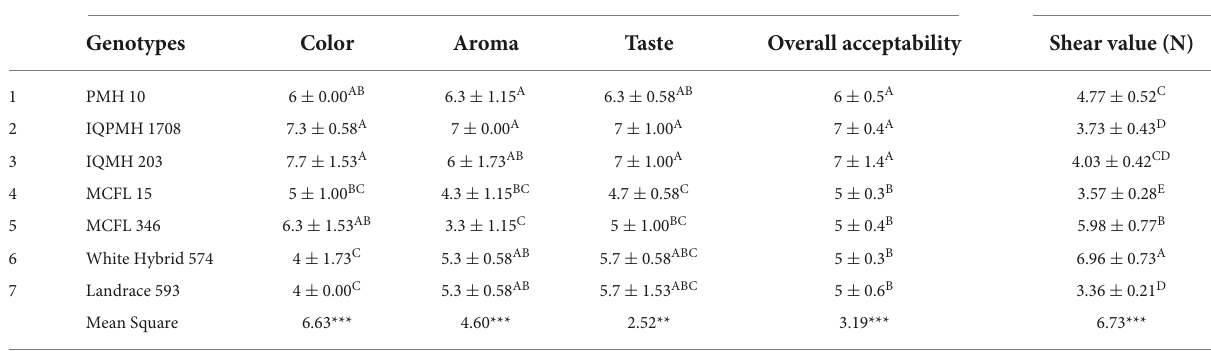
TABLE 6 Sensory attributes and textural properties (Shear Value) of Chapatti from different